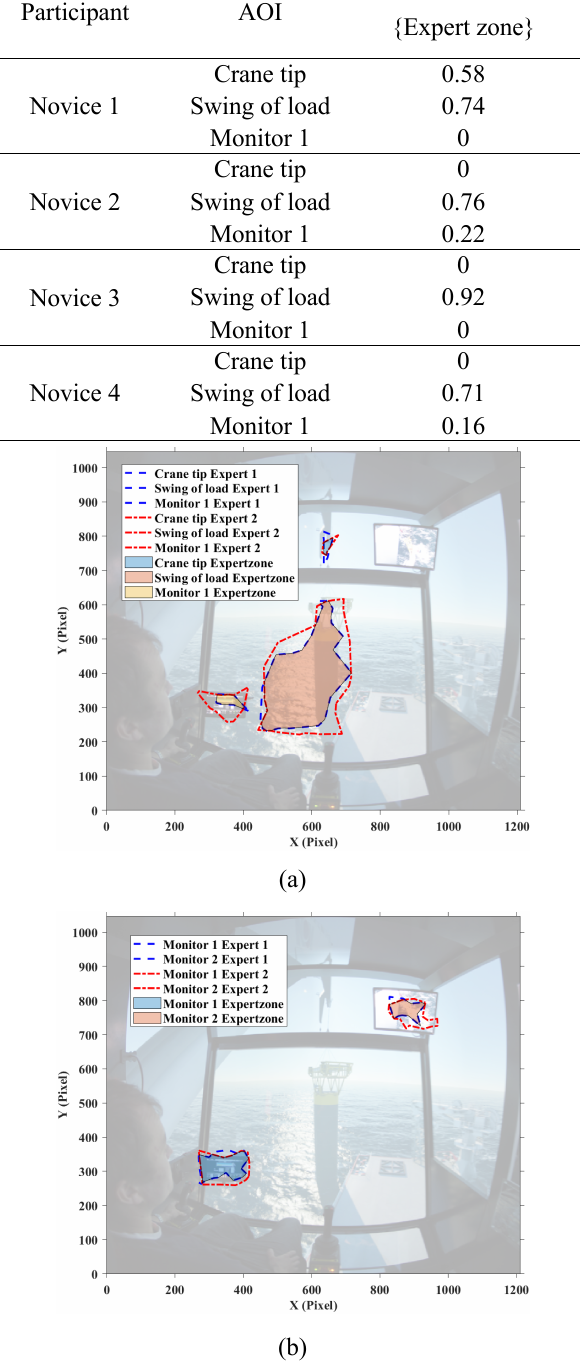
Figure 10: Defined ‘Expert zone’ in (a) target stage one, and (b) target stage